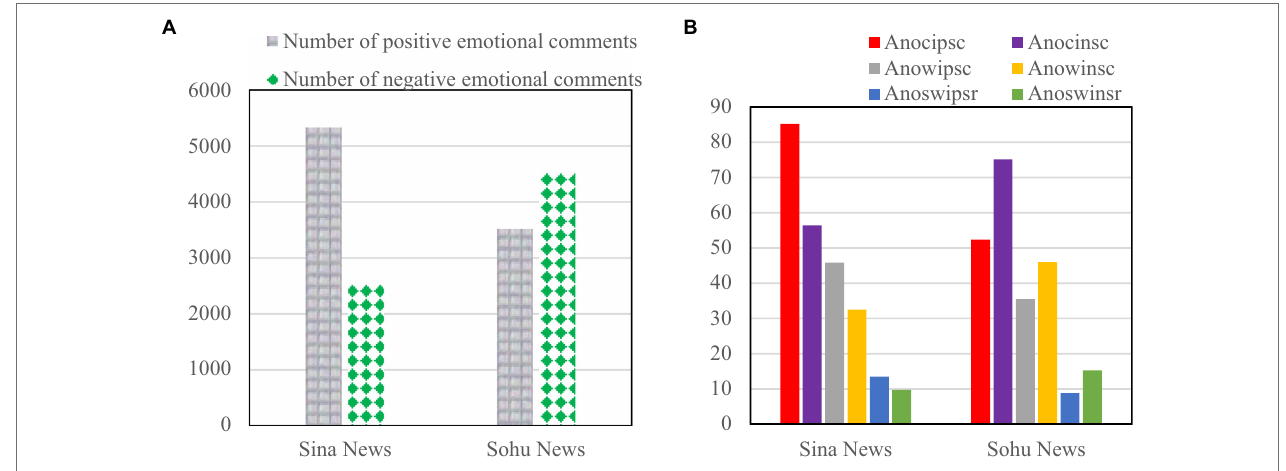
FIGURE 7 | Information on the experimental dataset of news sentiment commentary. (A) Shows the number of positive/negative sentiment comments on Sina News and Sohu News. (B) Shows the average number of positive/negative.